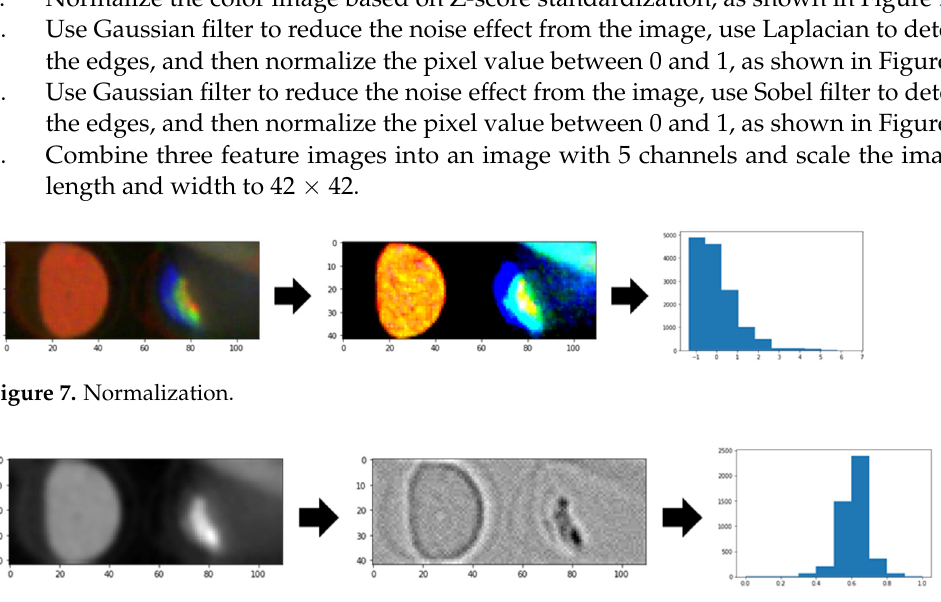
Figure 6. Color scale differences of A and B machines.